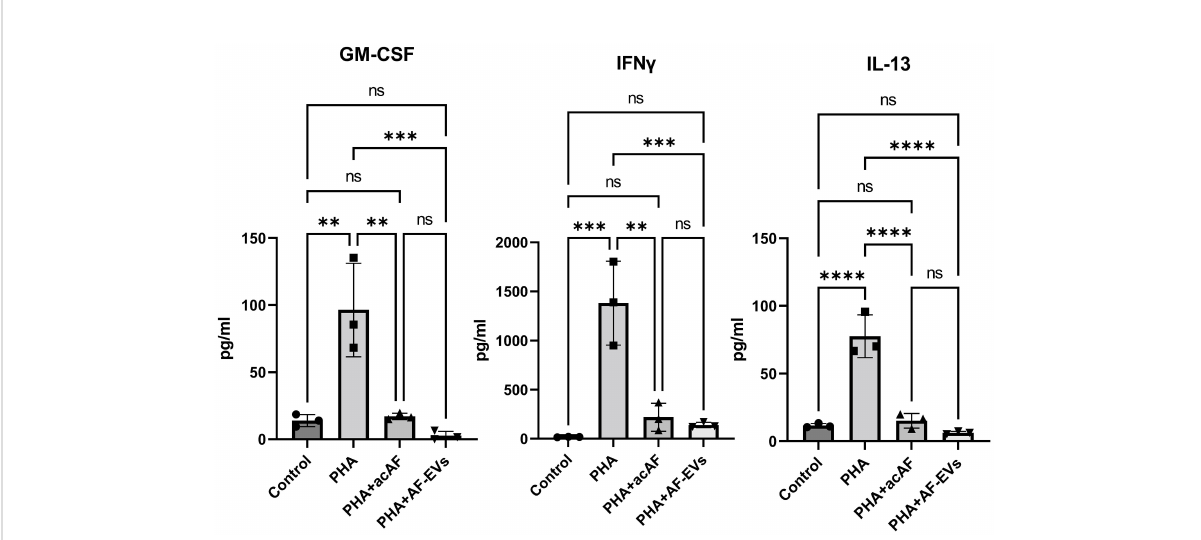
FIGURE 6 AcAF and AF-EV Treatment Reduce PBMC Pro-In fl ammatory Cytokine Release Extracellular levels of pro-in fl ammatory cytokines released into media were measured after 3 days of culture (Data graphed as mean ± SD; One way ANOVA with Tukey ’ s test; n=3 for each group; **=p<.01; ***=p<.001; ****=p<.0001; ns=not signi fi cant. Data is derived from 3 separate experiments. Each experiment used 1 independent PBMC donor treated with 1 of the 2 acAF and 1 of the 2 AF-EV donors).